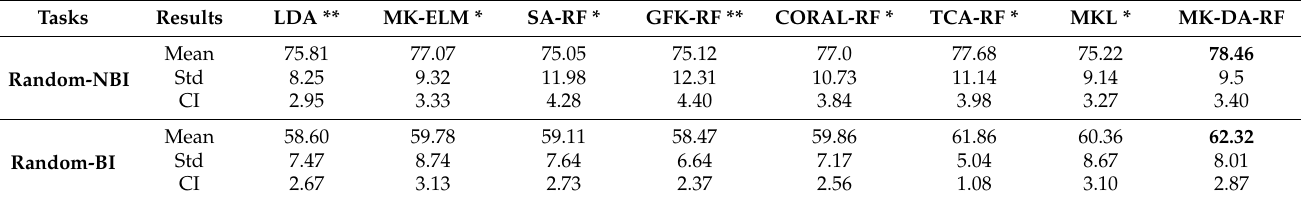
Table 1. A comparison of the different distribution adaptation methods for the source and target data from different